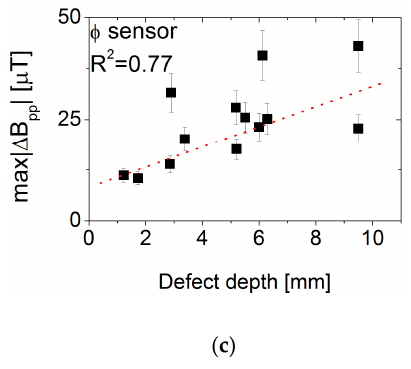
Figure 11. Dependence of maximum peak-to-peak change in magnetic field amplitude on ( a ) defect volume, ( b ) defect area in the r – z plane, and ( c ) defect depth.